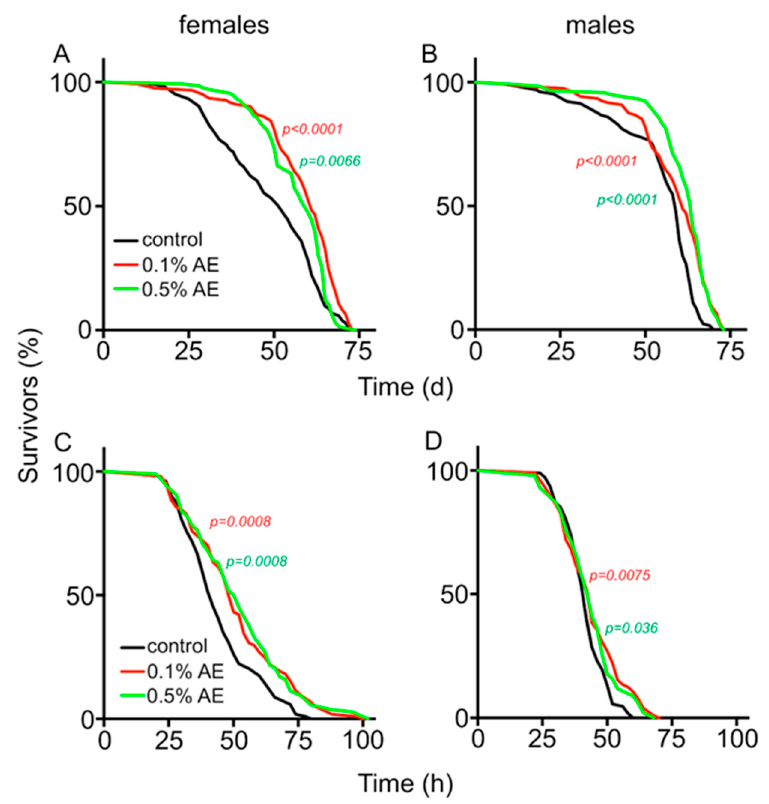
Figure 2. Lifespan analyses of female ( A ) and male flies ( B ), subjected to continuous drought (20% humidity) and normal food (black line), normal food supplemented with 0.1% BAE (red line), or 0.5% BAE (green line), were quantified. Statistical analysis (see Figure 1, n > 100 for each experiment). Starvation resistance of female ( C ) and male ( D ) flies that were fed on normal media (black lines) or on normal food supplemented with 0.1% BAE (red lines) or 0.5% BAE (green lines). Statistical analysis (see Figure 1, n > 100 for each experiment).